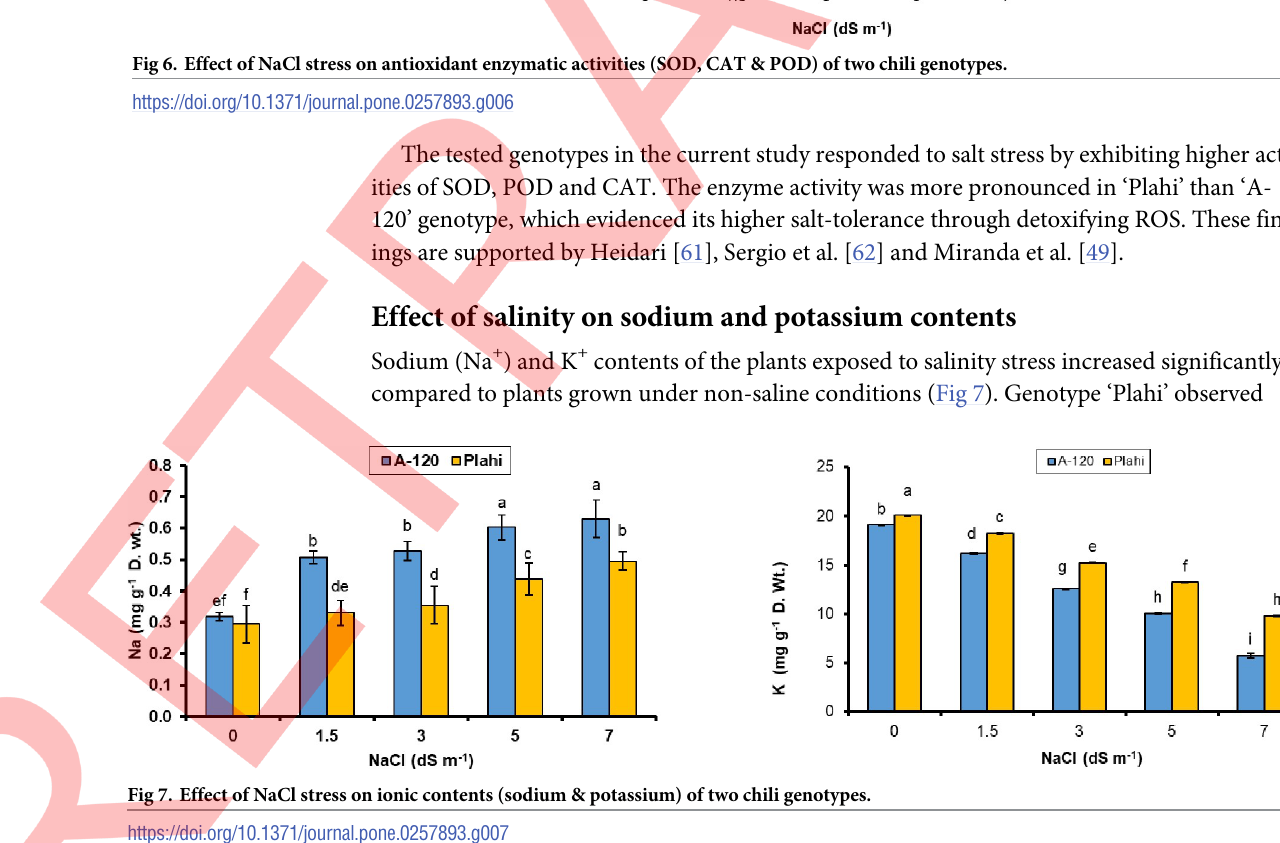
PLOS ONE | https://doi.org/10.1371/journal.pone.0257893 November4,